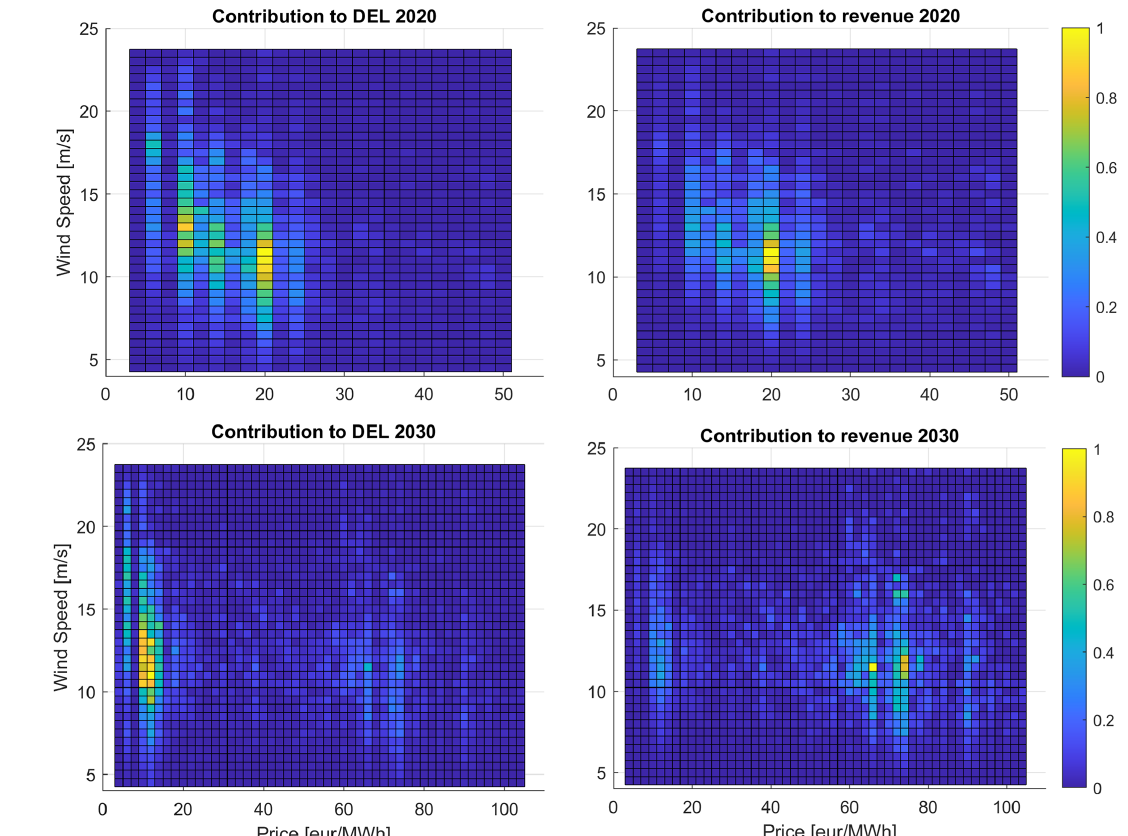
Figure 5. Contribution of price and wind speed bins to revenue and damage equivalent load (DEL) of blade root out-of-plane moment (BROop), obtained by multiplying the counts of each bin with the response obtained with the baseline wind turbine controller in simulations with the full data sets for 2020 and 2030. All values are normalised to the maximum value for the specific year and metric. Note that regions with high contributions to revenue on the right are strongly correlated to the bins with (below rated) wind speed and direction in Fig. 1 included in the showcase with high day-ahead electricity prices.